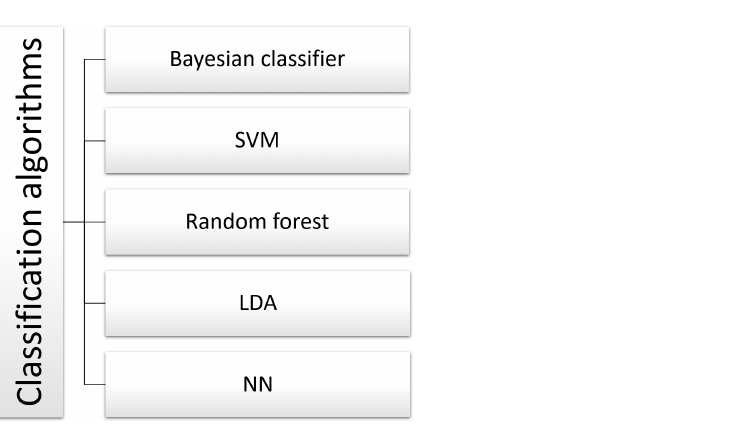
Figure 10. High-level taxonomy and related works for classification algorithms. Associated bib- liographic references: bayesian classifier [59,78], SVM [63,70,74,80], random forest [66], LDA [60,68,69,71,77], and NN